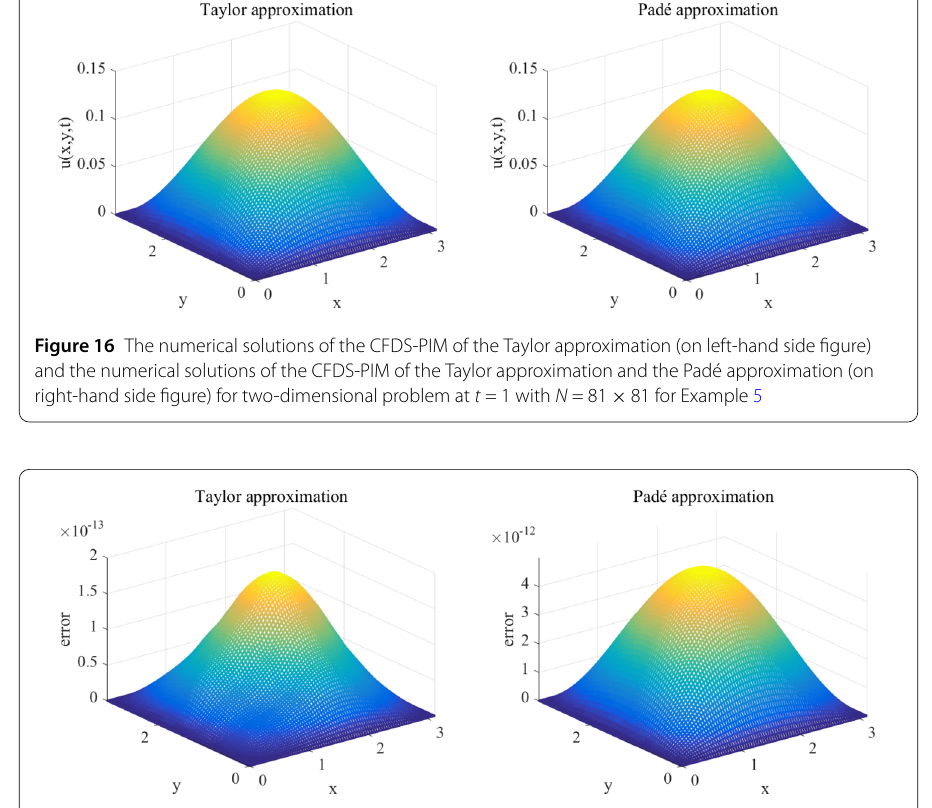
Table 8 Numerical results of two-dimensional parabolic problem and the spatial step at t = 1 for Example 5